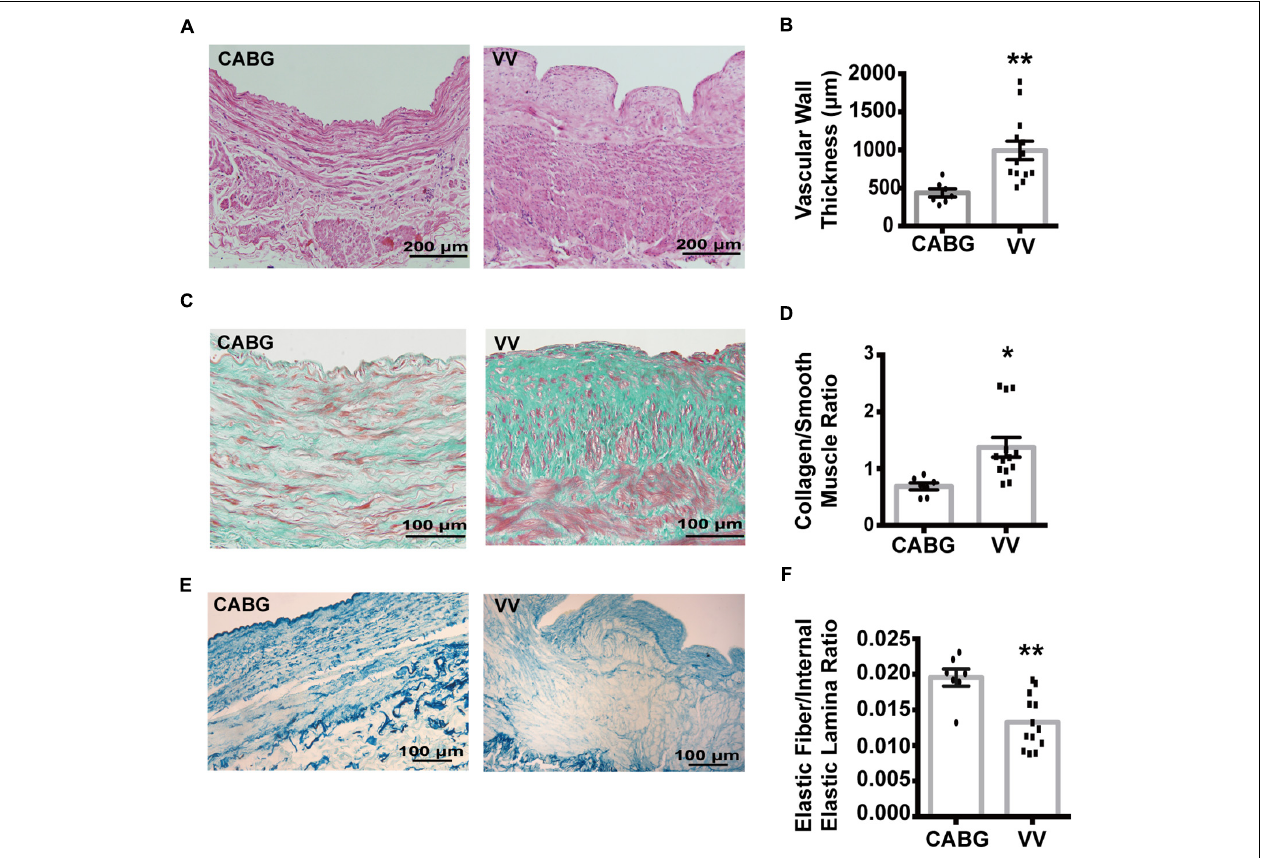
FIGURE 5 | The thickness of vascular wall, tunica intima, tunica media and collagen/smooth muscle ratio were significantly increased, the elastic fiber/internal elastic lamina ratio was decreased in varicose veins. (A) Representative photomicrographs of hematoxylin-eosin staining for vascular wall thickness. (B) Box plot showed that vascular wall thickness was significantly increased in varicose veins. (C) Representative photomicrographs of Vitoria blue staining for elastic fiber. (D) Box plot showed that the elastic fiber/internal elastic lamina ratio was decreased in varicose veins. (E) Representative photomicrographs of Masson staining for vascular smooth muscle and collagen. (F) Box plot showed that the collagen/smooth muscle ratio were significantly increased. ∗∗ P < 0.01; ∗ P <